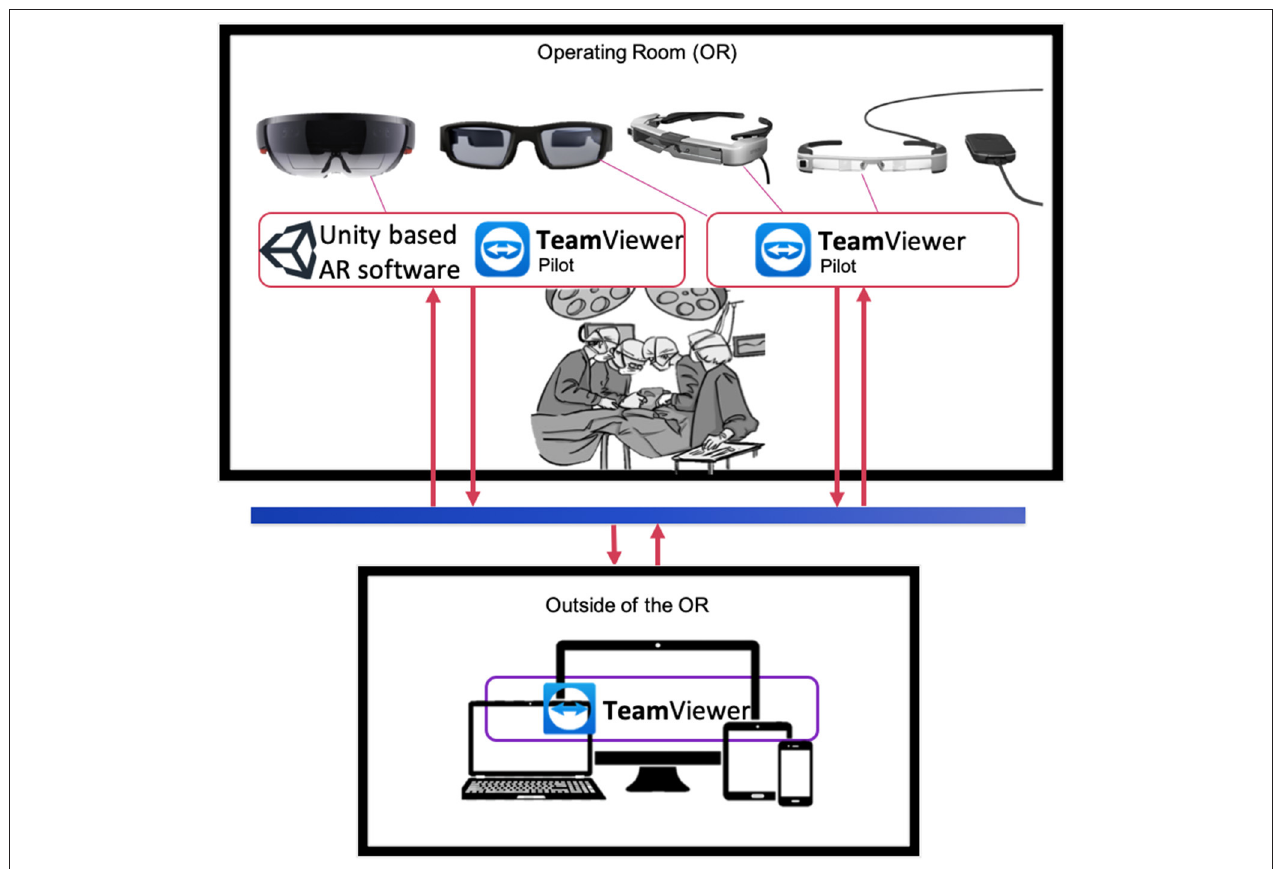
FIGURE 1 | Graphical representation of AR information flow between OR and remote users. Top panel: key personnel in the OR (i.e., physician, technical specialists, surgeons) wearing AR goggles equipped with software for digital content superimposition (Unity custom tool) and/or video streaming and interaction (e.g., Teamviewer Pilot) from the OR. Goggles models from the left: Microsoft Hololens, Vuzix Blade, Epson BT-350, Epson BT-300. Bottom panel: personnel outside the OR can visualize the video streaming from goggles equipped with Teamviewer Pilot via TeamViewer app on laptops, tablets or smartphones.